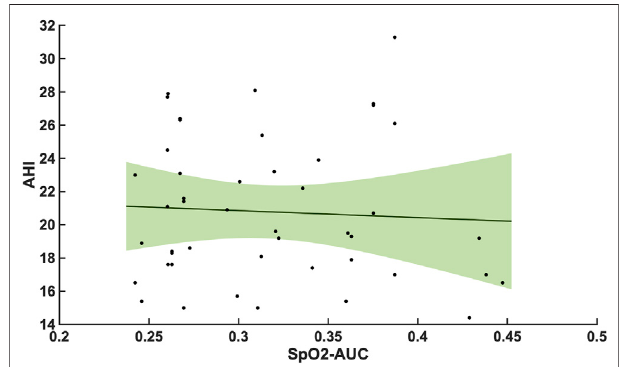
FIGURE 7 | Shows the linear regression results between the AHI and SpO2-AUC for patients with AHI > 30/h of TST. The orange margins indicate the standard deviation for the correlation and the black dots indicate each subject in this group. r = -0,0480/ p = 0.728/ n =